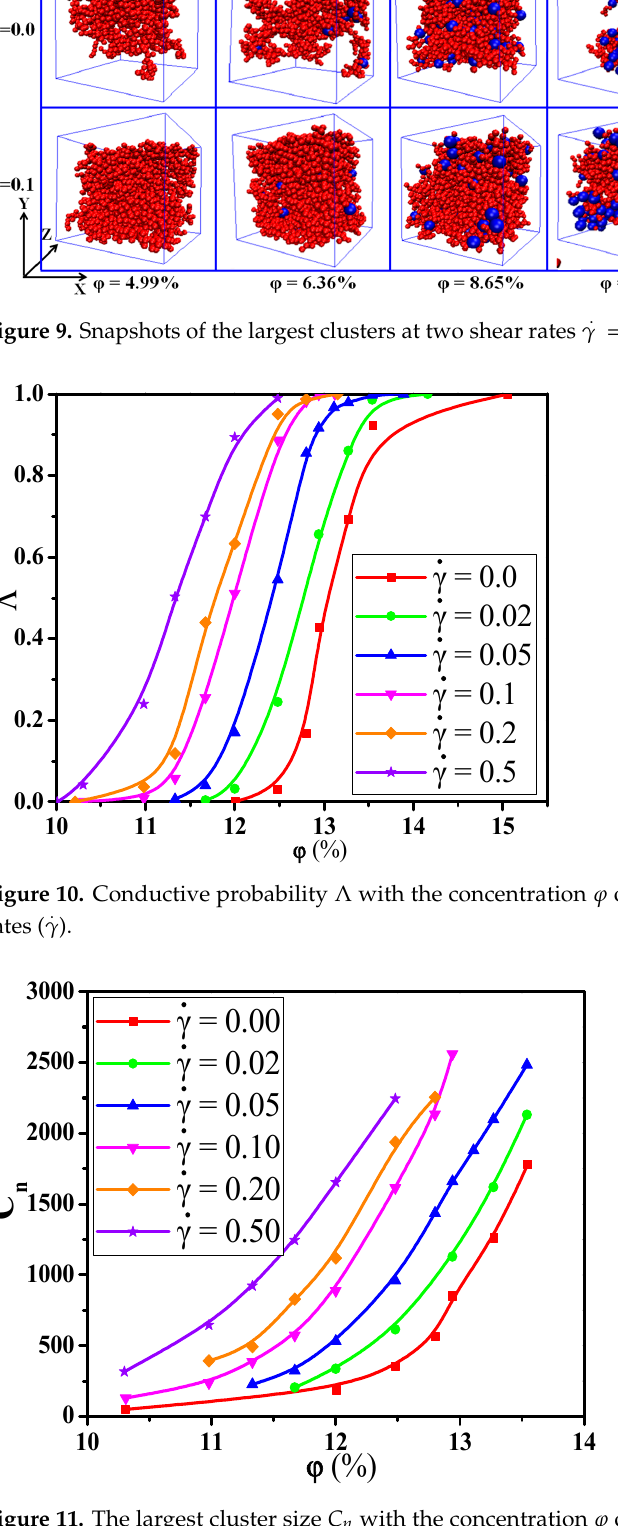
Figure 11. The largest cluster size n C with the concentration ϕ of nanoparticles for different shear rates ( 𝛾(cid:4662)